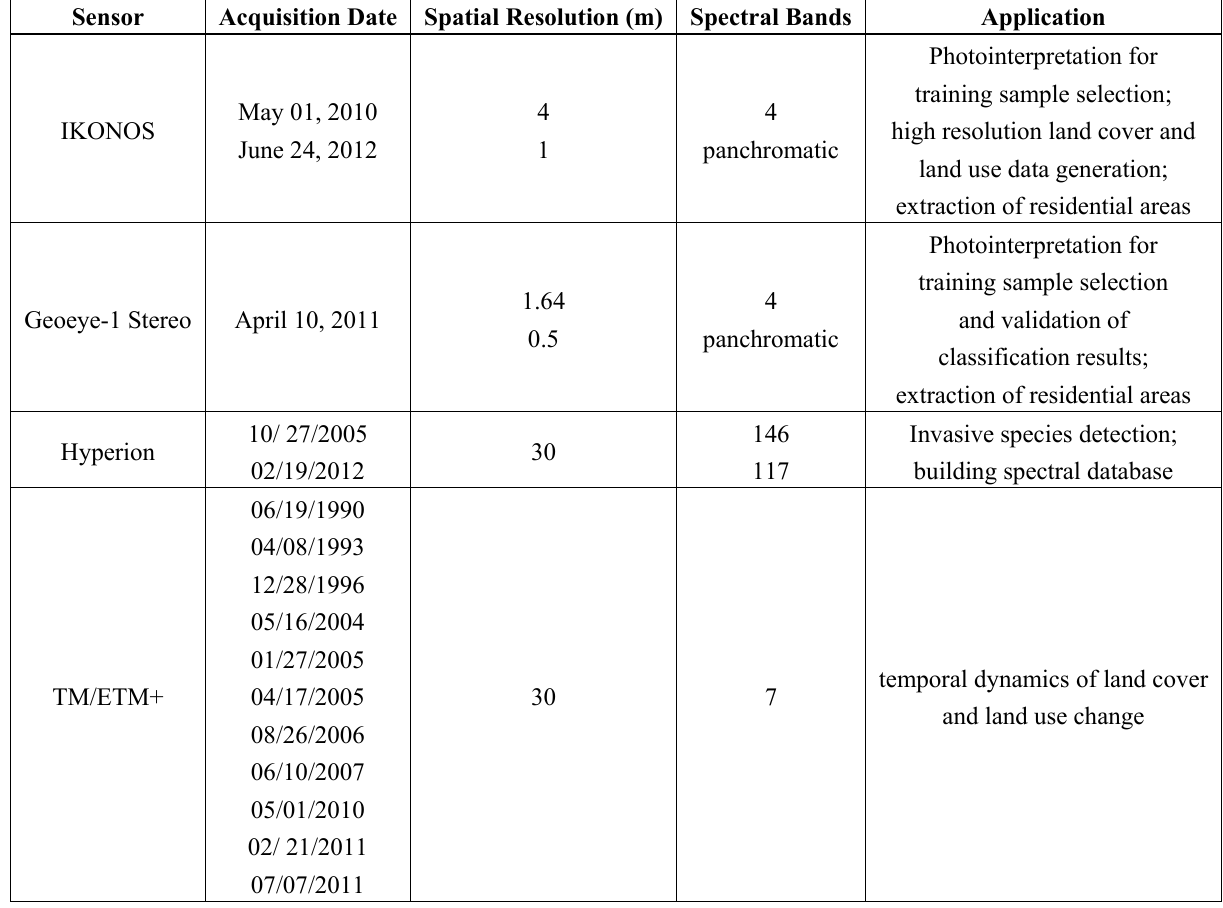
Table 1. Remote sensing data used in this